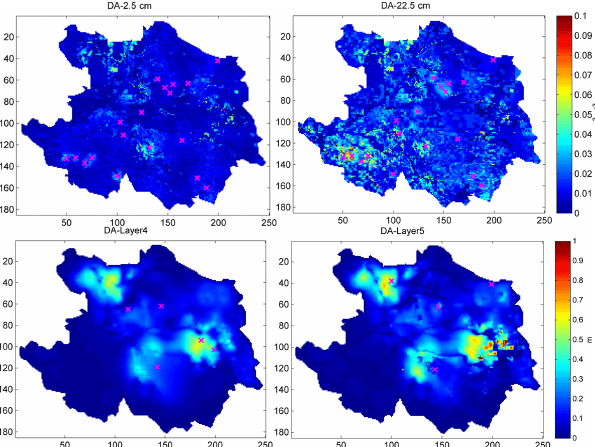
Figure 9. Spatial RMSD between assimilated and deterministic models in the Ahlergaarde catchment: soil moisture at 2.5cm depth (upper left) and 22.5cm depth (upper right), groundwater head at layer 4 (lower left) and layer 5 (lower right). The observation loca- tions at each layer are marked with violet crosses.